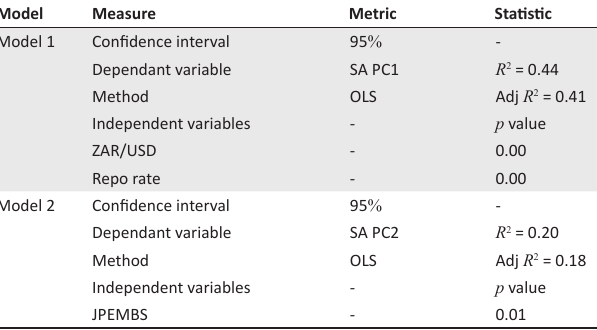
TABLE 4: Multivariate regression results: Sub-period 1. Model